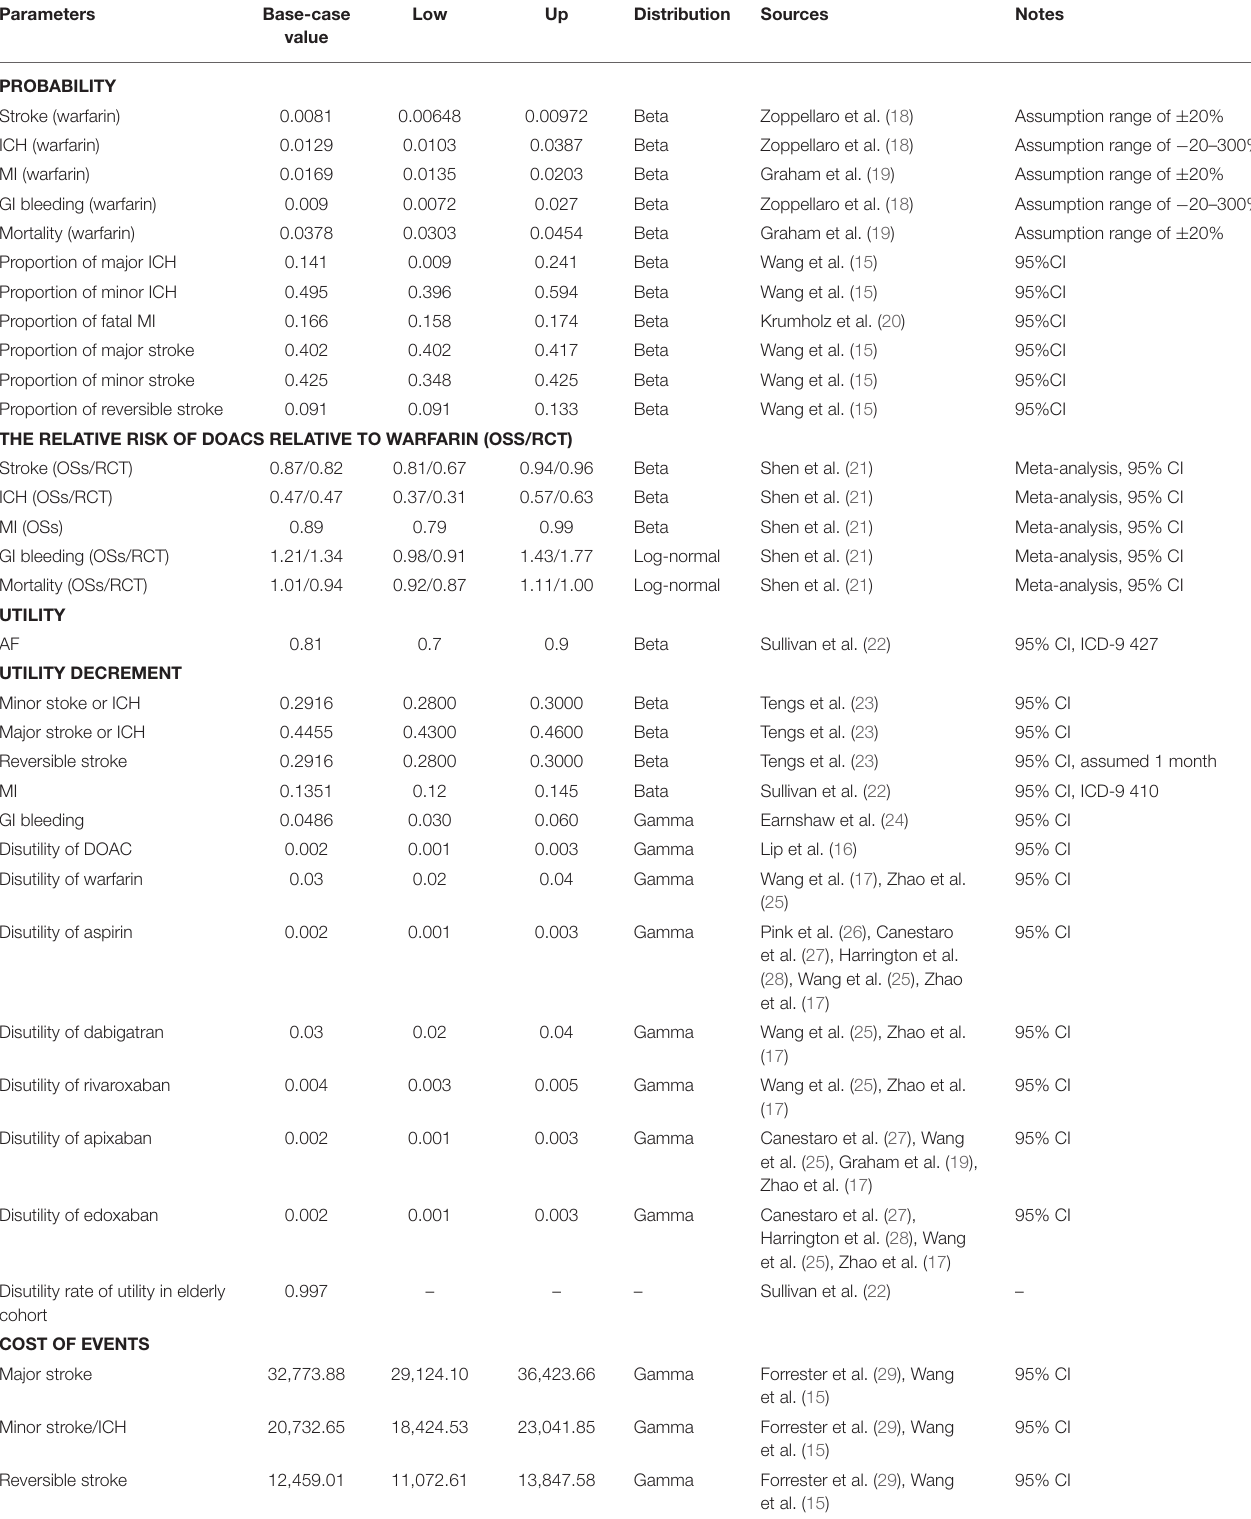
TABLE 1 | Parameters